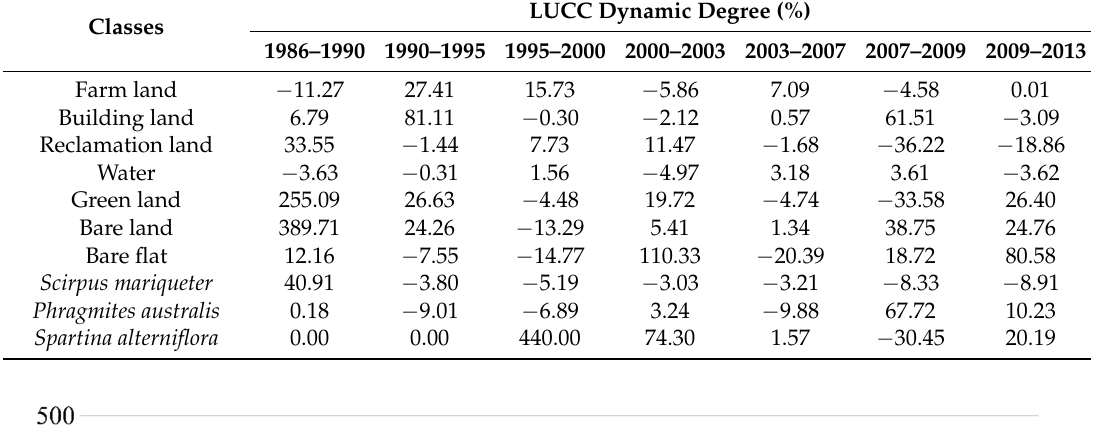
Table 5. Land-use/cover changes (LUCC) dynamic degree of different objects from 1986 to 2013 ( Spartina alterniflora was introduced into Chongming Island after 1995).